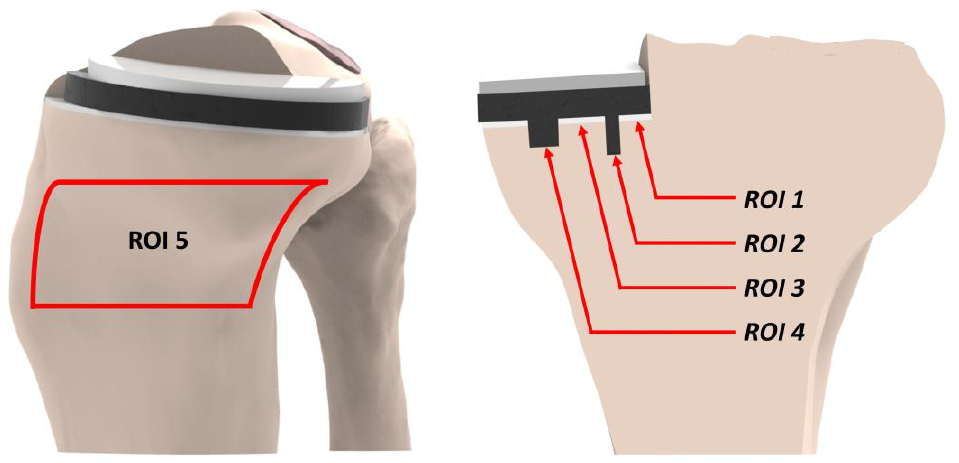
Figure 3. Five regions of interest (ROIs) of the tibia